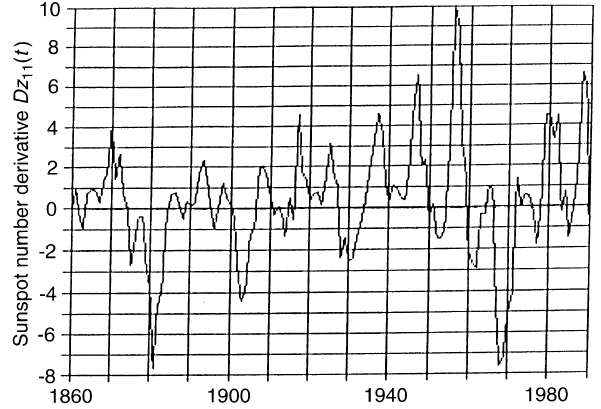
Fig. 6. Long-term